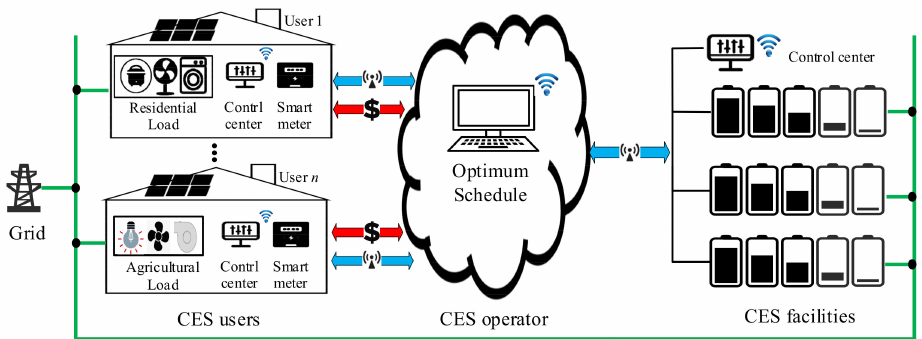
Figure 2. Model of CES